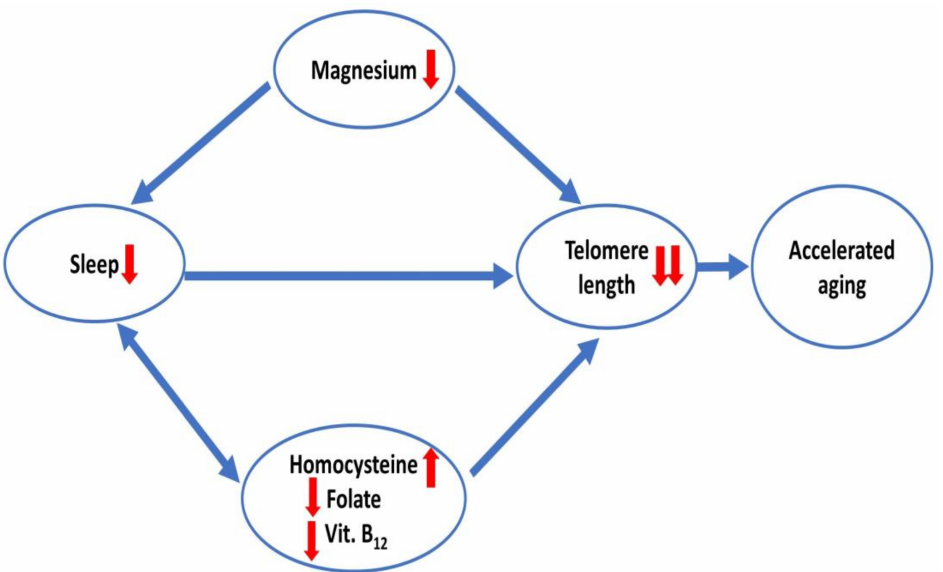
Figure 6. Magnesium as a mediator of the effects of sleep and homocysteine (in association with folate and vitamin B 12 ) on telomere length leading to accelerated